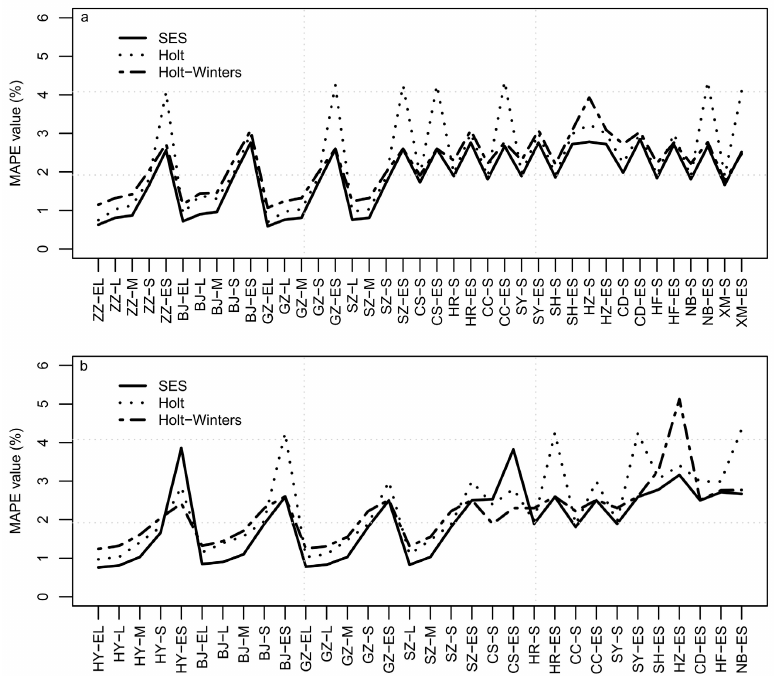
Figure 5. The MAPE value for three models. ( a ) ZZ group; ( b ) HY group.